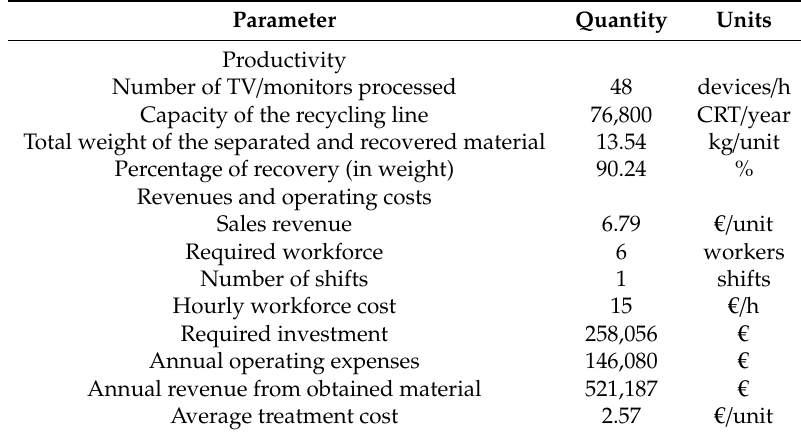
Table 4. Main parameters for economic analysis.